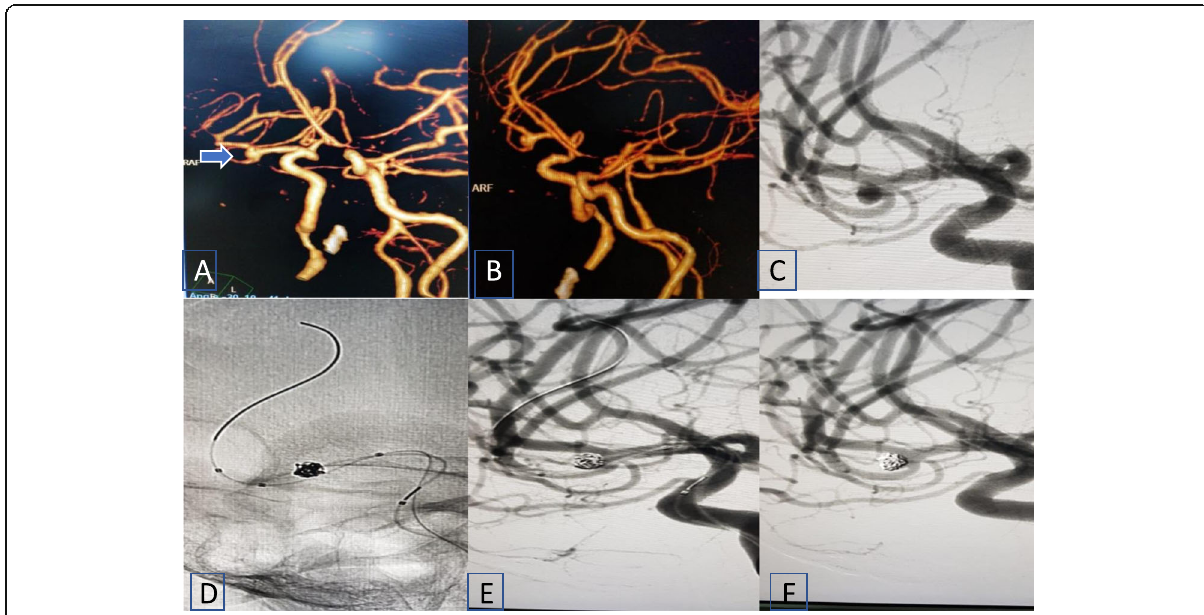
Fig. 3 Successful balloon-assisted coiling of M2 bifurcation aneurysm. A , B Reconstructed MDCT imaging of the aneurysm. C Diagnostic angiogram showing the wide neck of the aneurysm. D Intra-procedural with the balloon and the deployed coils within the sac. E After coil packing, intra-procedural. F Follow-up with stable dense packing, no recanalization